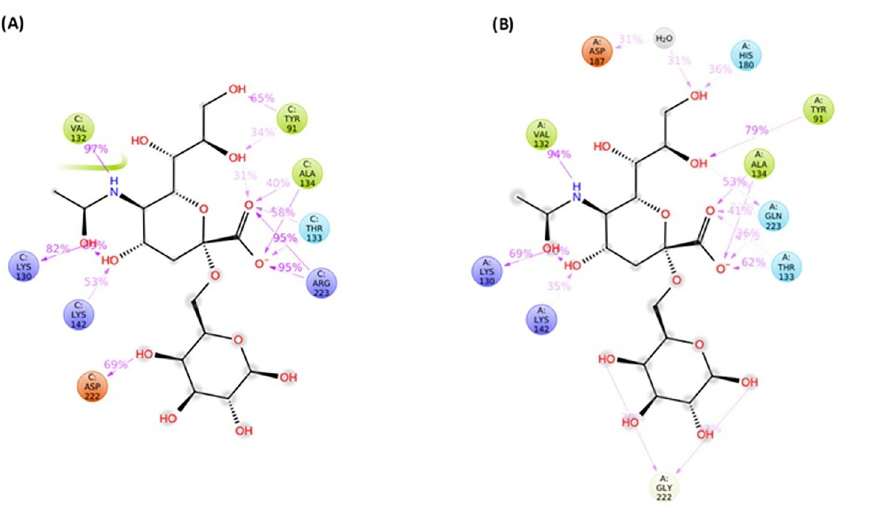
Fig 7. Binding network of A/SLOV15 S13 has additional interactions which may justify improved affinity to 6-SLN receptor analogue relative to A/SLOV15 V1. (A) Summary of the interactions between 6-SLN receptor analogue and A/SLOV15 V1 and (B) A/SLOV15 S13 HA proteins during molecular dynamics simulations. 6-SLN receptor analogue is shown in black and interacting receptor binding site residues are coloured by charge/polarity and mapped with percentage interaction values. Interactions that are present less than 30% of the simulation time are not shown (500ns simulation, n = 3).